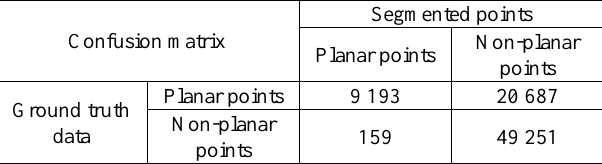
Table 10. Confusion matrix of results of PCA